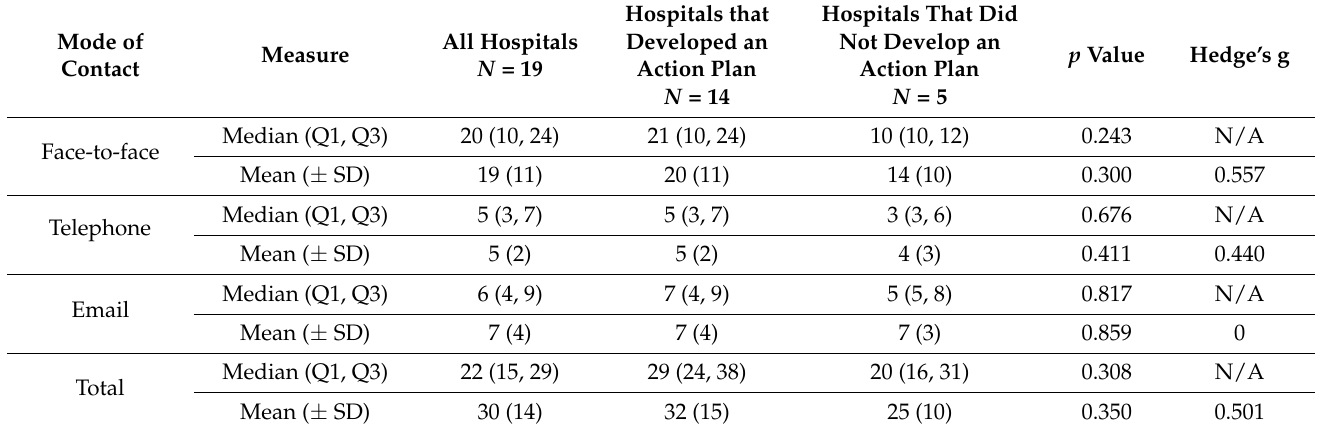
Table 2. Median and mean hours of external facilitator support and development of action plans.